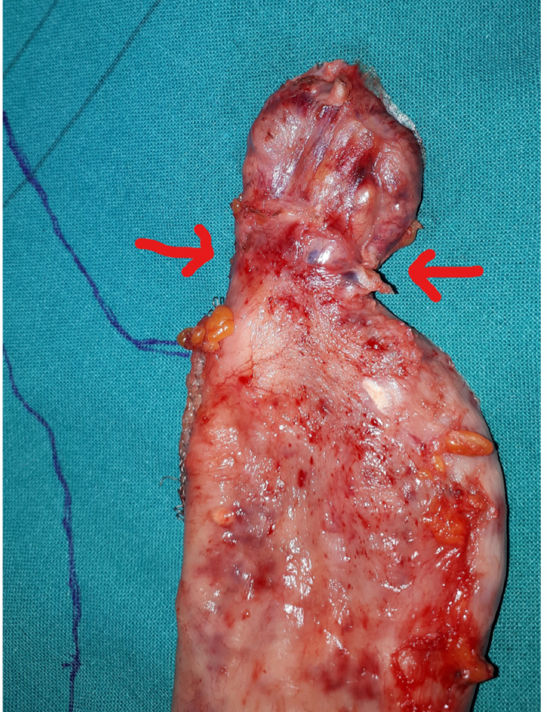
Figure 4. Gastric specimen after sleeve gastrectomy. Red arrows: Neck of the diverticulum.